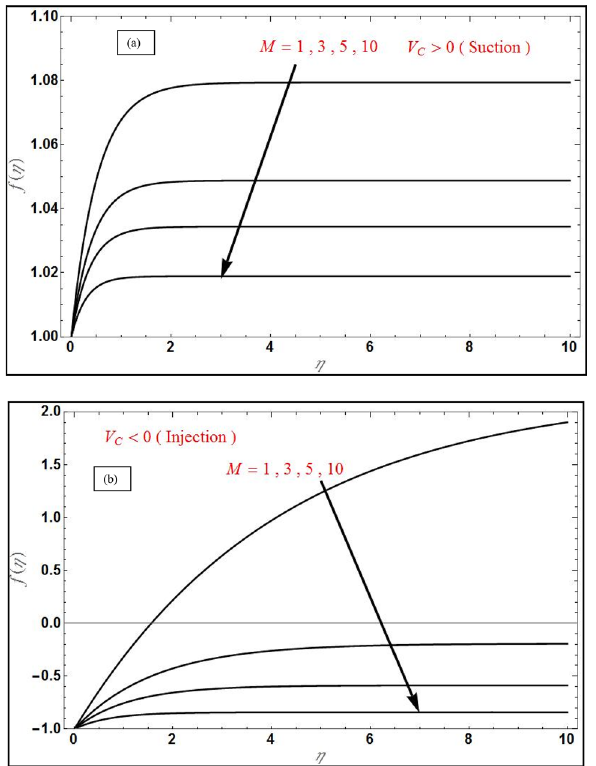
Figure 2. Transverse velocity profile f (η) for varying magnetic parameter ( M ) for ( a ) suction ( V C = 1 ) and ( b ) injection ( V C = − 1 ) with Da − 1 = (cid:31) = 1 , S 1 = 1, S 2 = − 1 , ϕ 1 = 0.1, ϕ 2 = 0.04